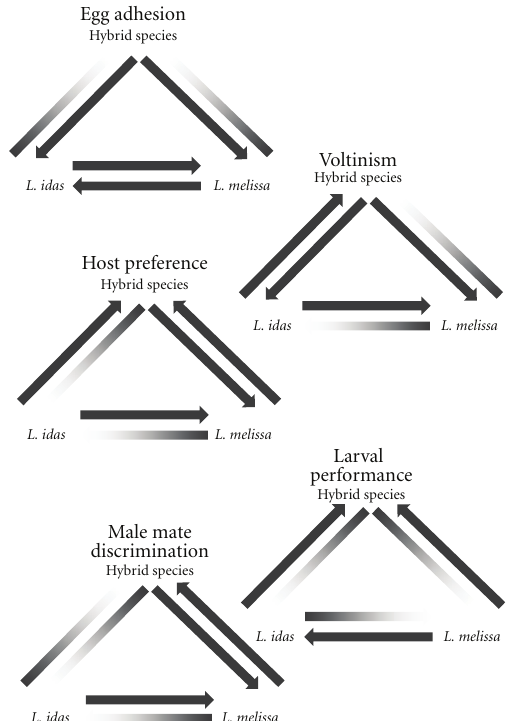
Figure 4: Summary of hypotheses relating ecological traits to reproductive isolation between taxa based on the current and past studies [16, 17, 19, 22, 23]. Arrows joining two taxa correspond to greater gene flow and those that are faded represent gene flow that could be prevented or reduced by a given trait. For details see